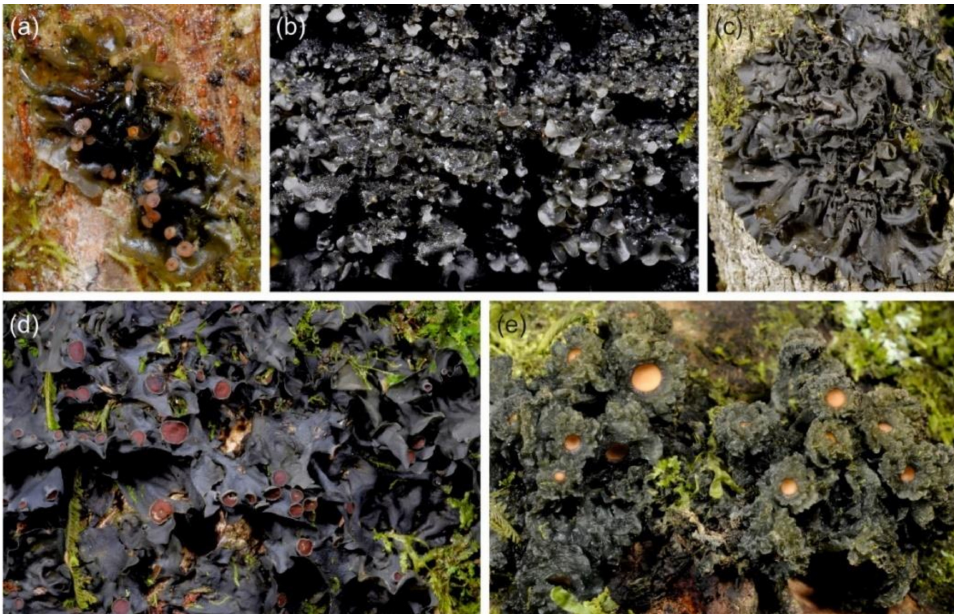
Figure 1. Examples of the Leptogium morphotypes from the montane forests of Kenya. ( a ) Fertile morphotype azureum. ( b , c ) The morphological variation within morphotype cyanescens include isidiate and phyllidiate species, as well as many transitional forms. ( d ) Morphotype cochleatum with a thick thallus and prominent apothecial margins. ( e ) Morphotype phyllocarpum with abundantly phyllidiate